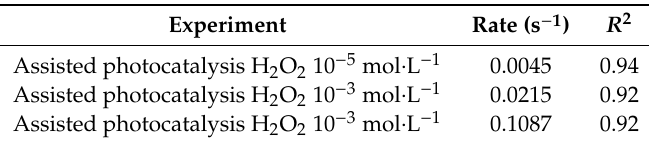
Table 1. Degradation rate constant k and the correlation coe ffi